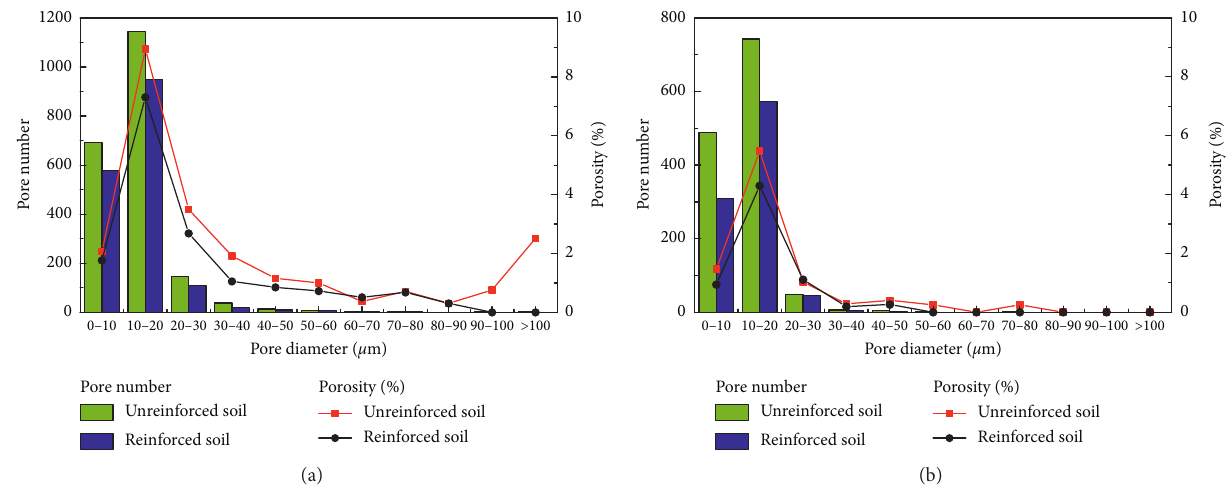
Figure 11: Porosity and pore number distribution in different diameter range under different loads. Pore distribution (a) before loading and (b) after loading ( τ �